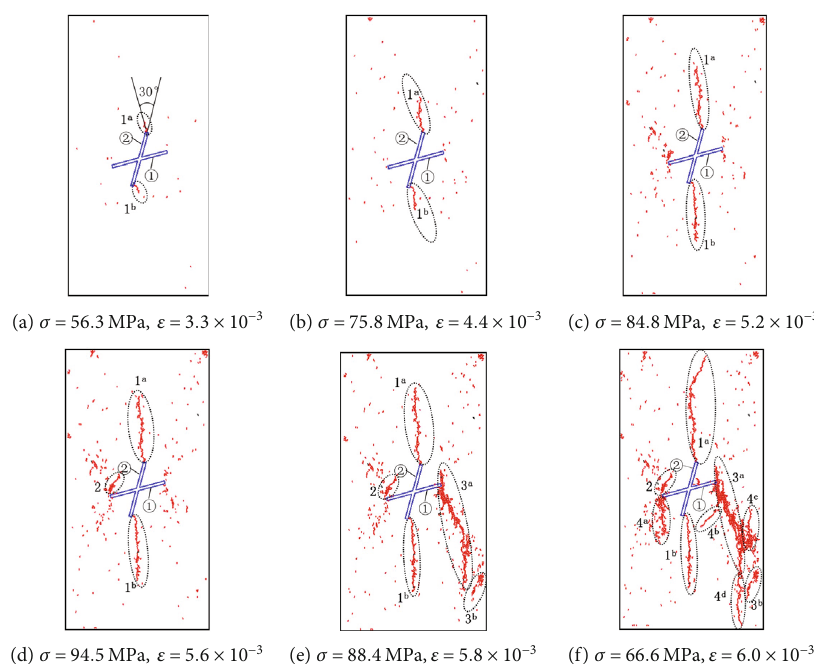
Figure 13: Crack propagation process during the loading process of the numerical model containing X-shaped fi ssure ( α = 45 ° , β = 60 ° ). (Red represents tensile microcracks. Black represents shear microcracks. Numbers indicate the order of macrocrack generation. The angle value indicates the crack initiation